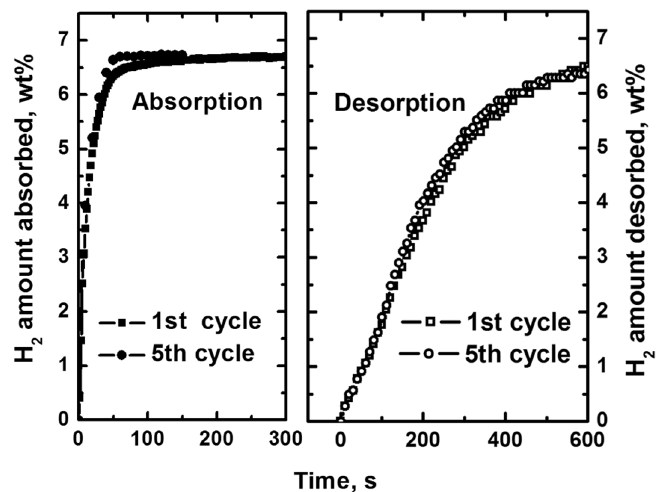
Figure 11. Hydrogen storage cycling stability for MV(4.5)cnt(0.5) sample after five cycles of absorption (200 °C) and desorption (300